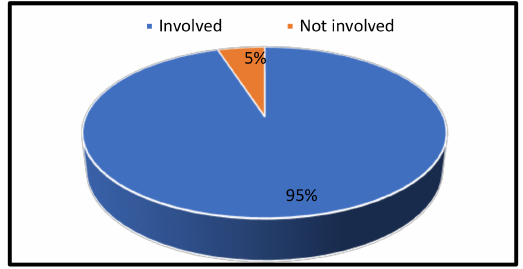
Figure 5. Direct involvement in the vegetable seed business.